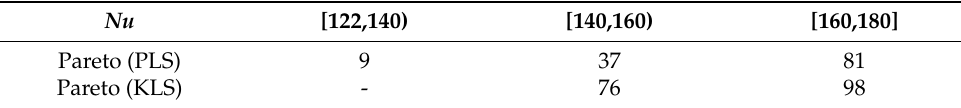
Table 4. The distribution for Pareto solutions of Nu for Op-I.